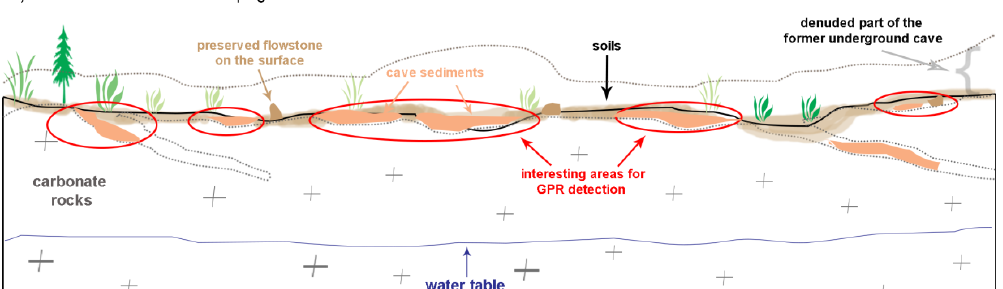
Figure 4. Schematic model of unroofed cave development: ( a ) Underground horizontal passage formed during karstification. When the water table started dropping, cave sediments were deposited and speleothems began to form. Dry passage filled with allochthonous and autochthonous sediments; ( b ) Denudation processes cut off the passage ’ s upper parts, so cave sediments are revealed on the surface. Weathering and surface processes reshape the karst surface.